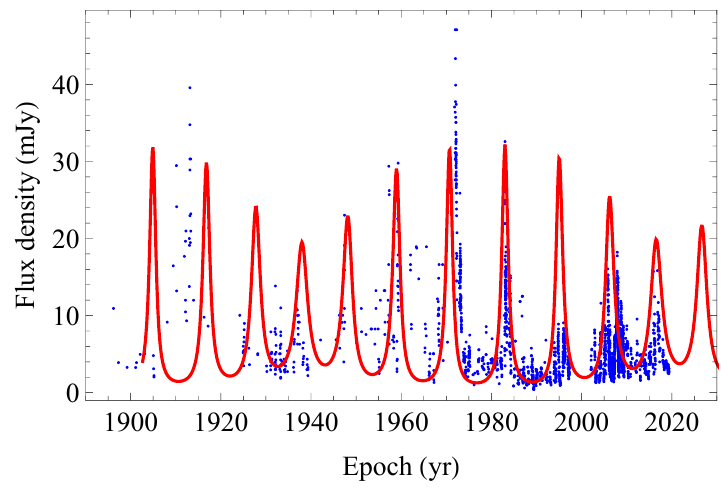
Figure 10. Observed data points (blue circles) and simulated light curve (red line) in V